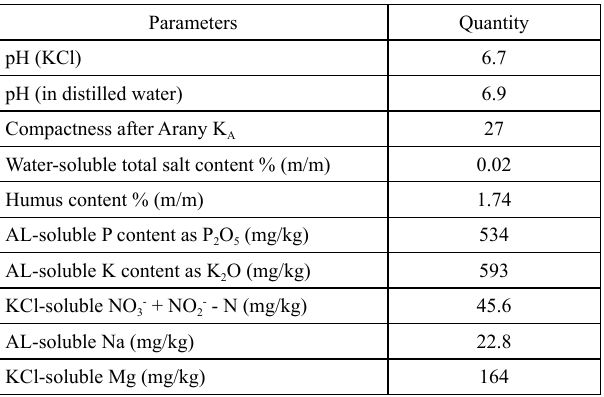
Table 2. Soil analysis data (Debrecen-Pallag,